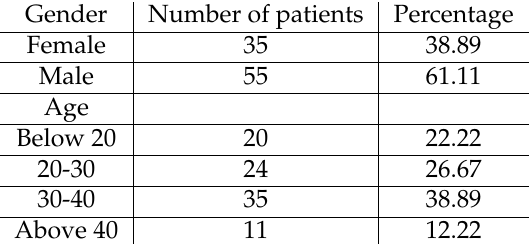
Table 1. Age and Gender distribution of